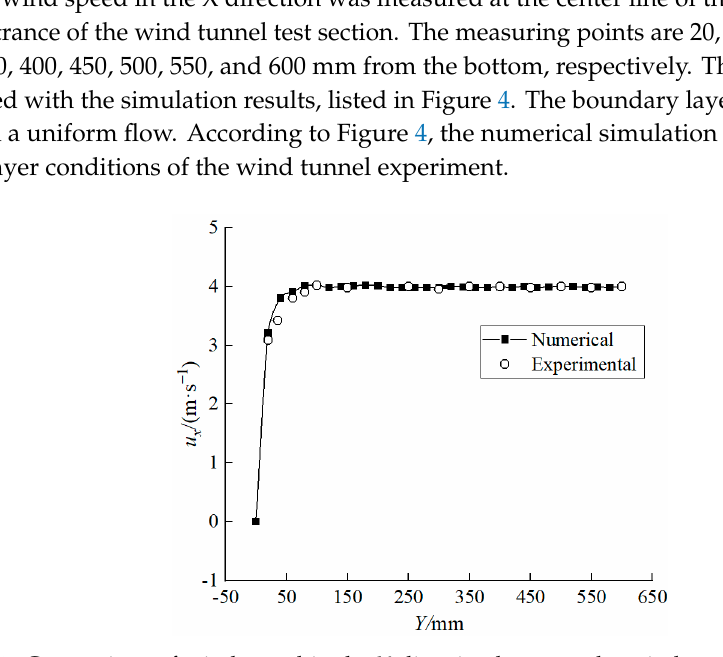
Figure 4. Comparison of wind speed in the X direction between the wind-tunnel experiment and numerical simulation on the inlet of 500 mm.